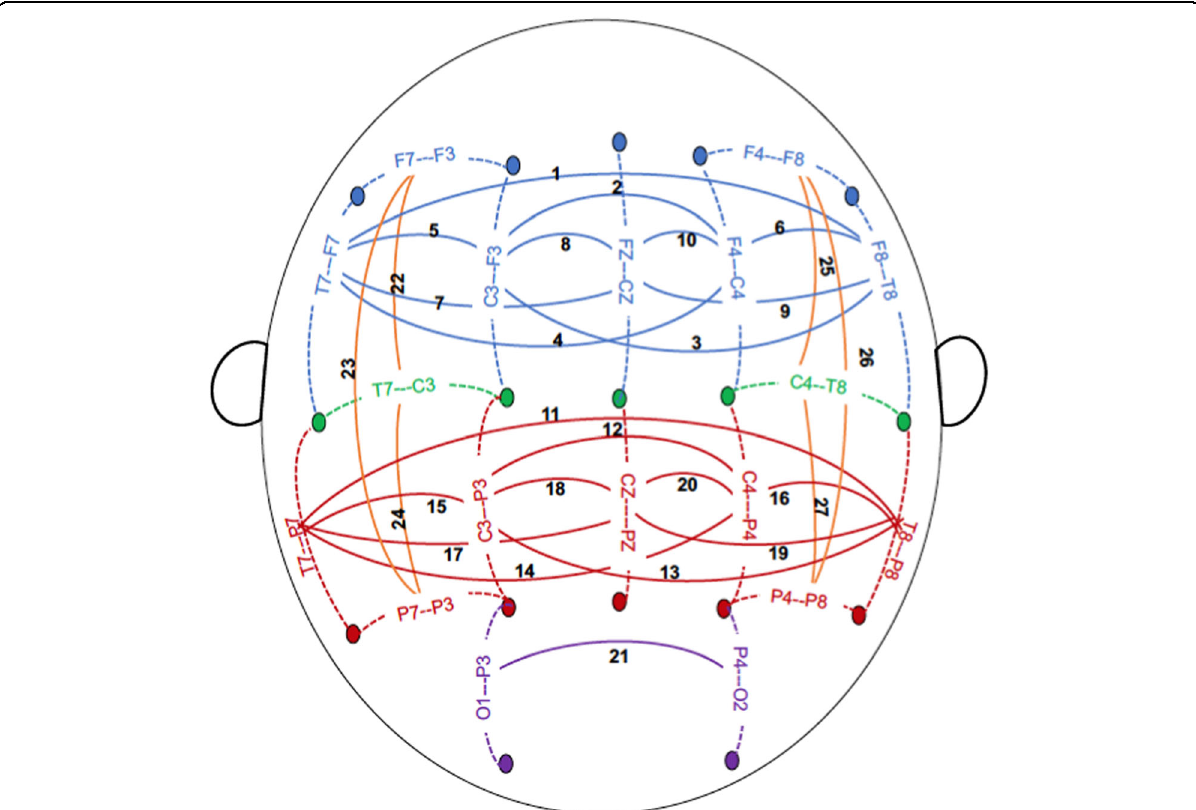
Fig. 1 Scalp topography of EEG electrodes used for the computation of coherence. The schematic represents a top view of the scalp, nose up. Coherence (solid lines) was computed between bipolar EEG signals, each of which was derived from a pair of adjacent electrodes (connected by dotted lines). Electrode labeling: letters F, C, T, P, and O represent frontal, central, temporal, parietal, and occipital areas of the scalp, respectively; odd and even numbers represent the left and right hemispheres, respectively, and “ Z ” denotes electrodes along the sagittal midline. 27 Coherences between bipolar electrode pairs are illustrated as follows: frontal-central sagittal coherences are represented in blue; (1) F8-T8--F7-T7, (2) F4-C4--F3-C3, (3) F3-C3--F8-T8, (4) F4-C4--F7-T7, (5) F3-C3--F7-T7, (6) F4-C4--F8-T8, (7) FZ-CZ--F7-T7, (8) FZ-CZ--F3-C3, (9) FZ-CZ--F8-T8, (10) FZ-CZ--F4-C4. Central- parietal sagittal coherences are represented in red; (11) T8-P8--T7-P7, (12) C4-P4--C3-P3, (13) C3-P3--T8-P8, (14) C4-P4--T7-P7, (15) C3-P3--T7-P7, (16) C4-P4--T8-P8, (17) T7-P7--CZ-PZ, (18) C3-P3--CZ-PZ, (19) T8-P8--CZ-PZ, (20) C4-P4--CZ-PZ, parietal-occipital sagittal coherences are represented in purple; (21) P4-O2--P3-O1. Intrahemispheric lateral coherences are represented in orange; (22) T7-C3--F7-F3, (23) P7-P3--F7-F3, (24) P7-P3--T7-C3, (25) T8-C4--F8-F4, (26) P8-P4--F8-F4, (27)